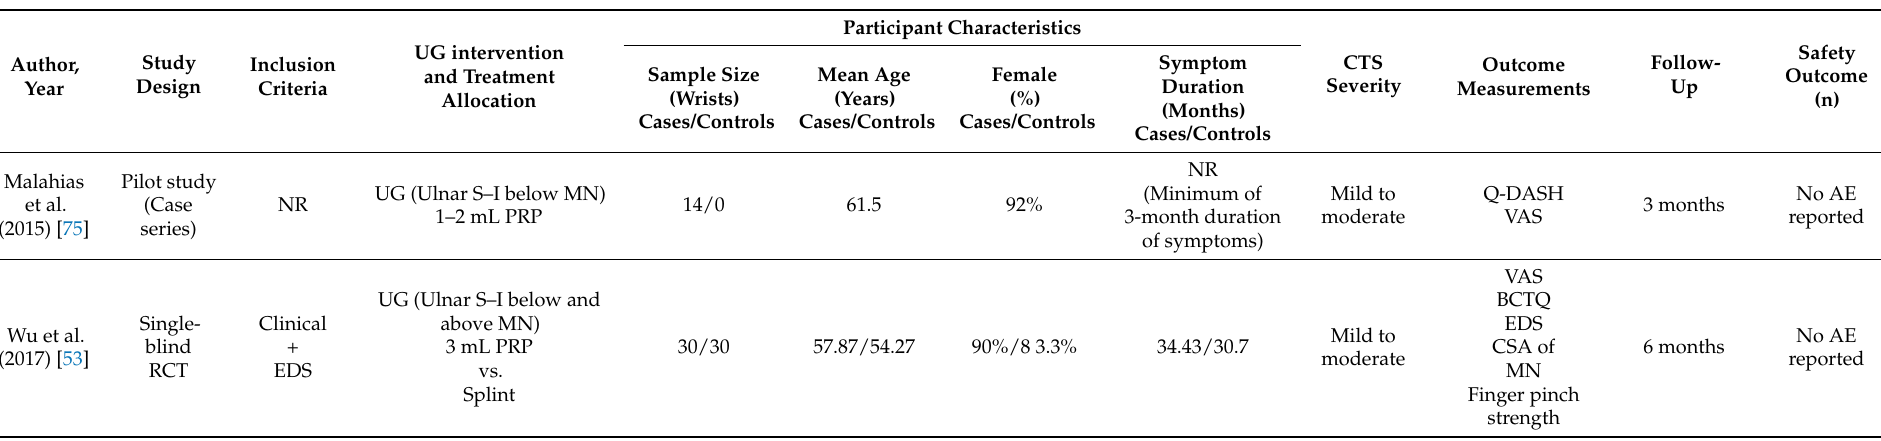
Table 6. Intervention details of included studies using ultrasound-guided PRP injection for treating carpal tunnel